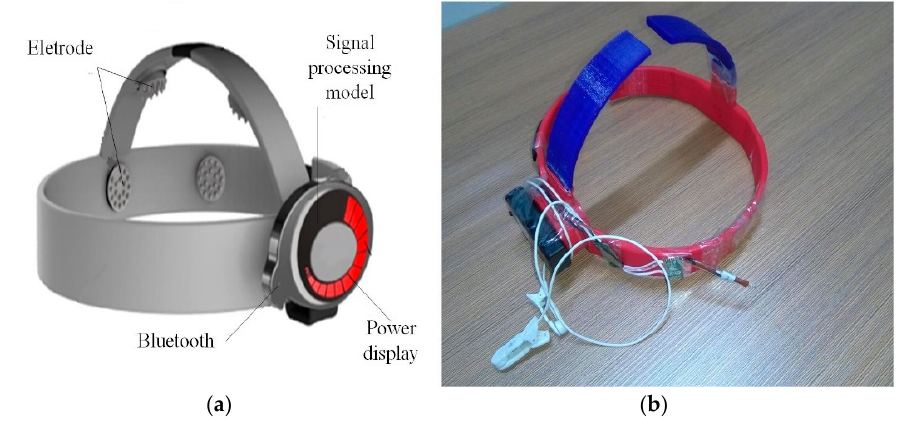
Figure 2. 8-channel wireless wearable BCI system. ( a ) BCI system model; ( b ) Homemade BCI system.